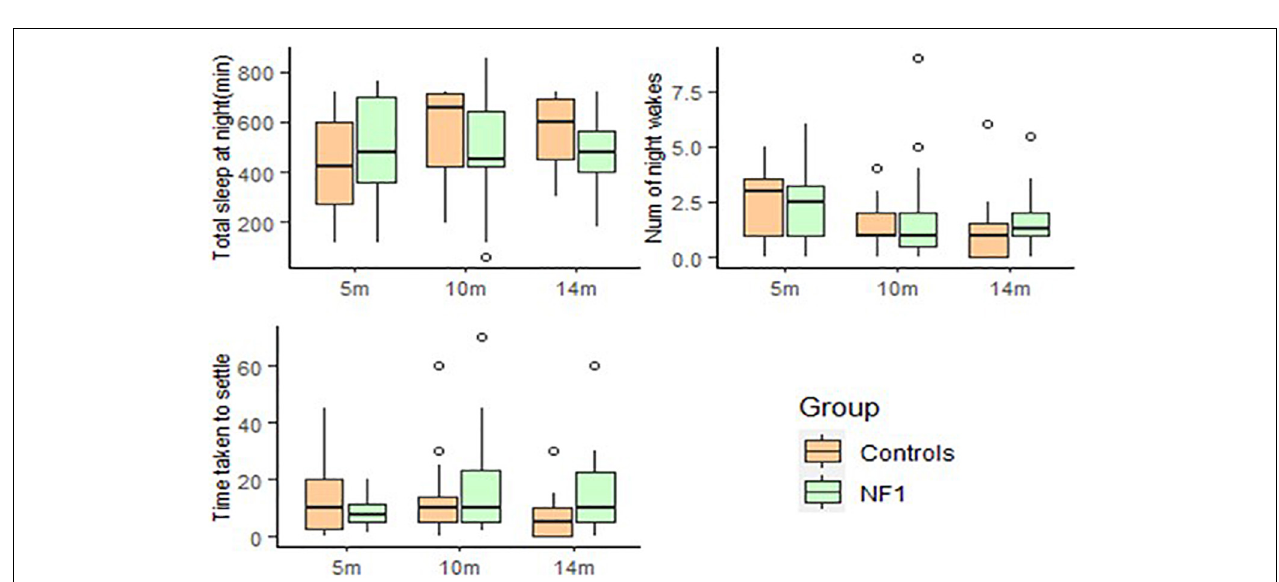
FIGURE 4 | Box-whisker plots for the NF1 and control group on the Sleep and Settle